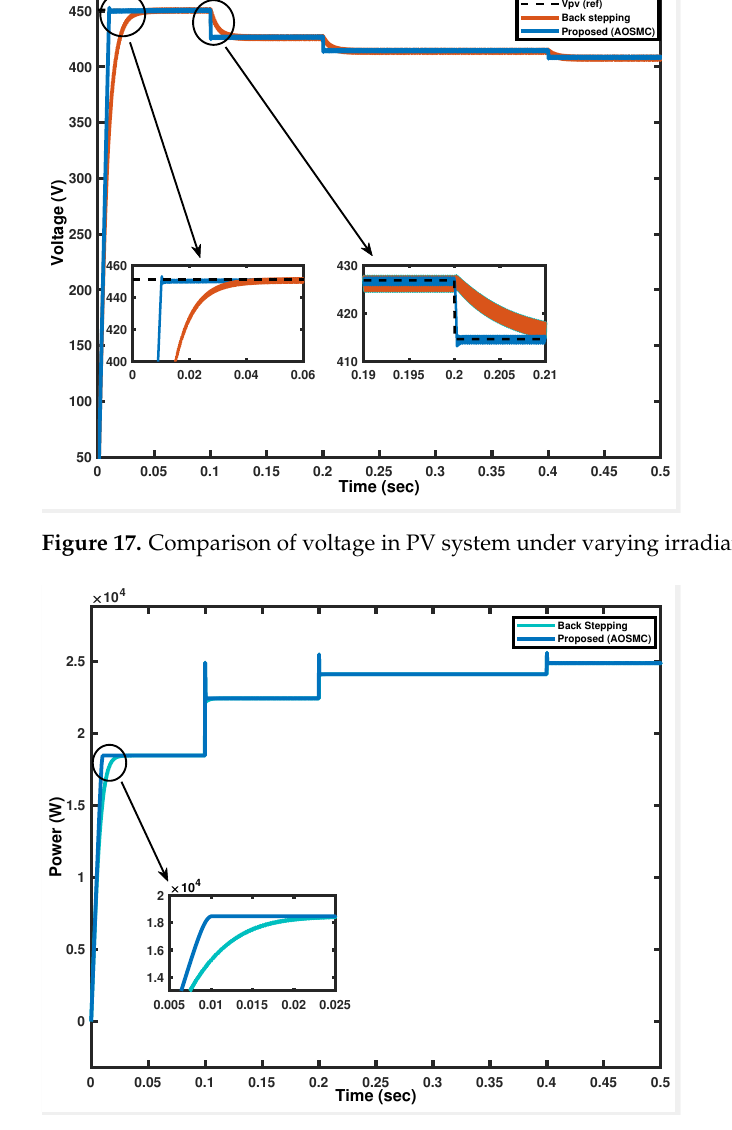
Figure 18. Comparison of the generated output power under varying